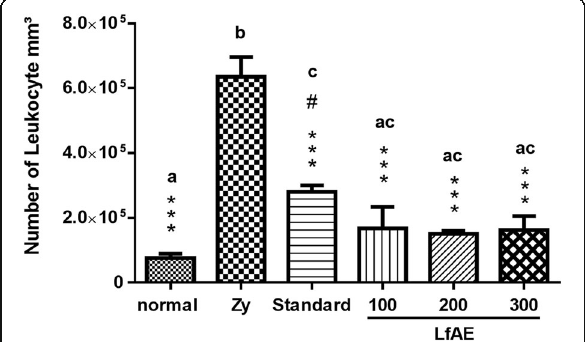
Fig. 2 Effect of LfAE (100, 200 and 300 mg/kg) on cellular fluid influx in the zymosan-induced arthritis model ( n = 6 per group). Data are expressed as mean ± SD (One-way ANOVA, Tukey-Kramer test, n = 6